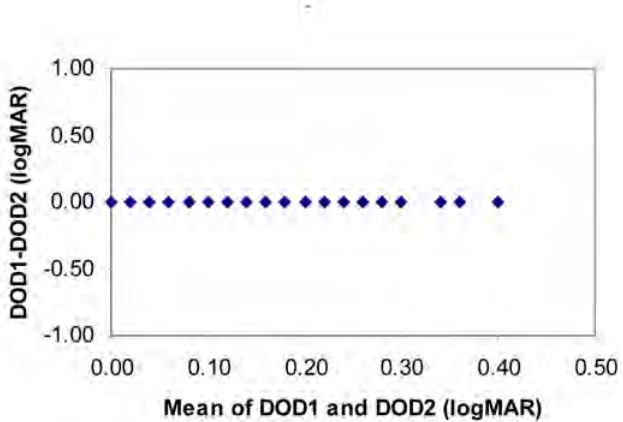
Figure 4 . Showing the Bland and Altman plot for the differenc- es (DOD1 and DOD2) of the unaided and aided logMAR values of the two methods. All the points align at 0.00 of the y -axis because all the differences (DOD1-DOD2) were zero. Also, the limit of agreement lines is not indicated because the differences are all